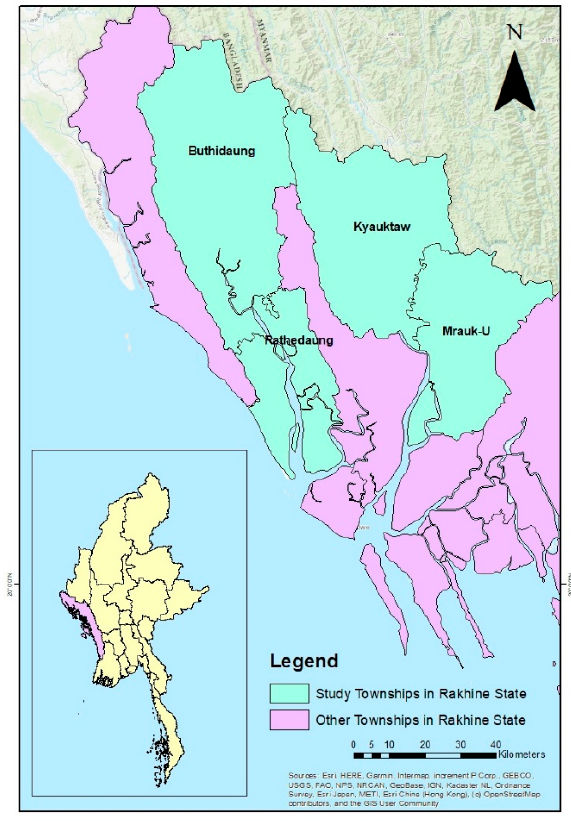
Figure 1. Map of Study Area.